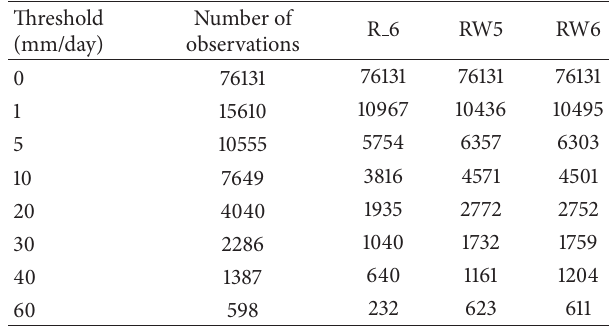
Table 2: Number of data equal to or above a given threshold for observations, R 6, RW5, and